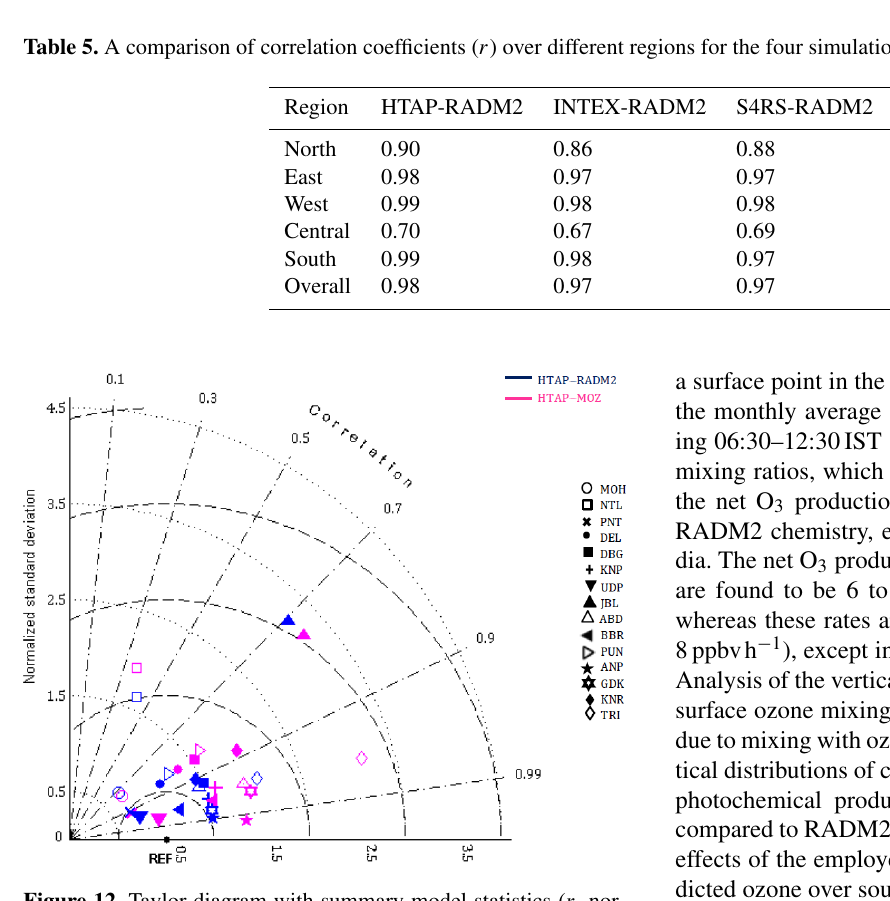
Figure 12. Taylor diagram with summary model statistics ( r , nor- malized SD and RMSD) at all sites. The correlation is the cosine of the angle from the horizontal axis, the root mean square difference is the distance from the reference point (REF) and the SD is the distance from the